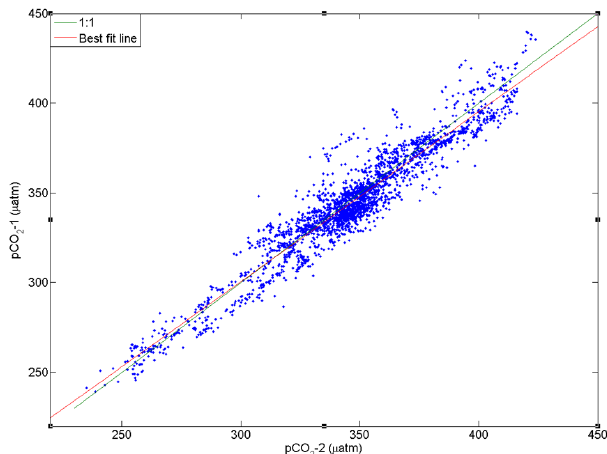
Figure 1. Relationship between two independently measured p CO 2 data sets. The line of perfect agreement (1 : 1 line, in green) and the best fit line (in red) are also